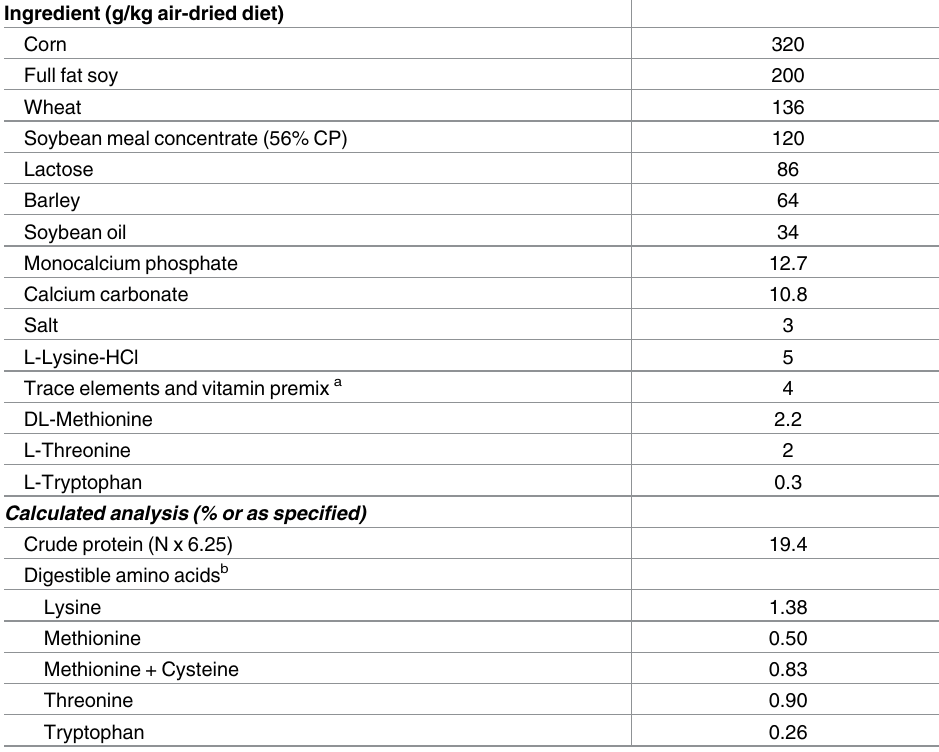
Table 1. Ingredients and chemical composition of the experimental diet.